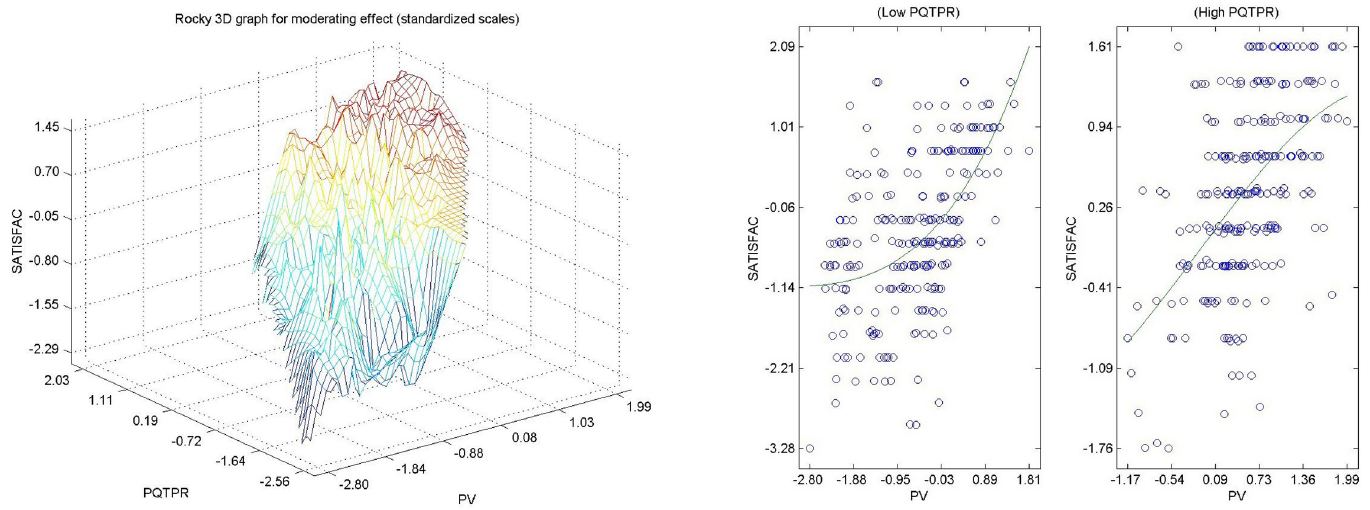
Fig 9. a. Hypothesis 7 3D, PQTRP- > PV-SATISFAC. b. Hypothesis 7 2D, PQTRP- >